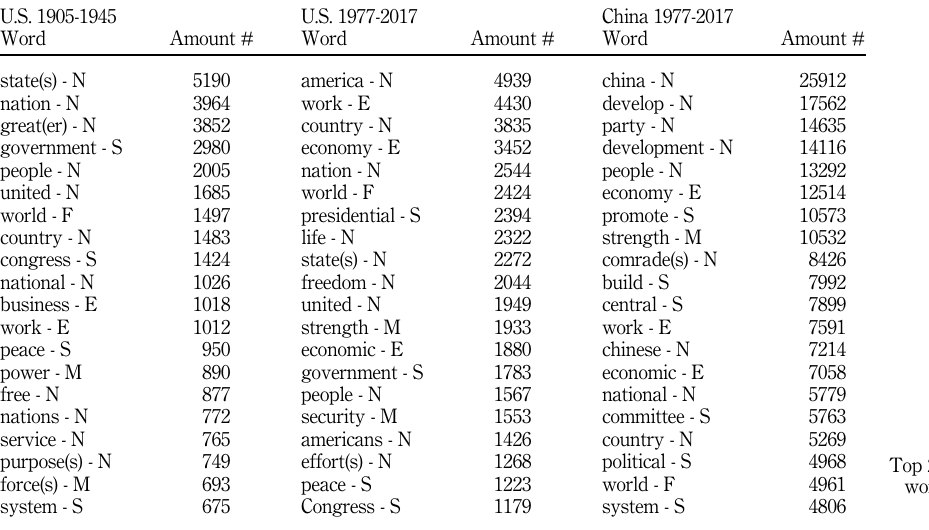
Table 1. Top 20 most common words for each time